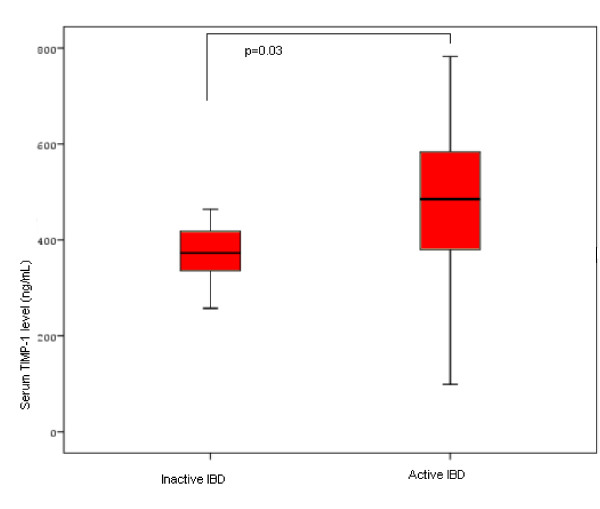
Bar graph showing TIMP-1 levels in patients with active and inactive IBD.